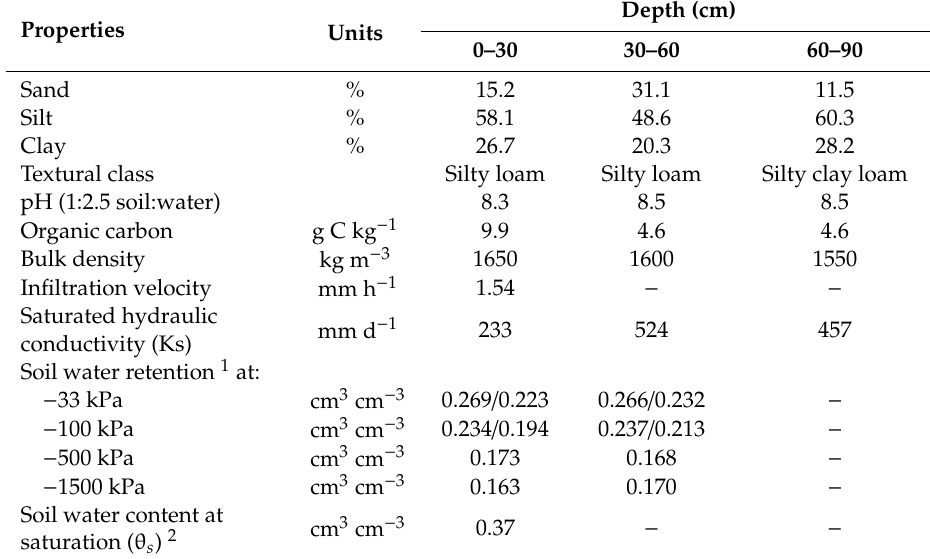
Table 2. Soil physical and chemical properties of the experimental site at di ff erent